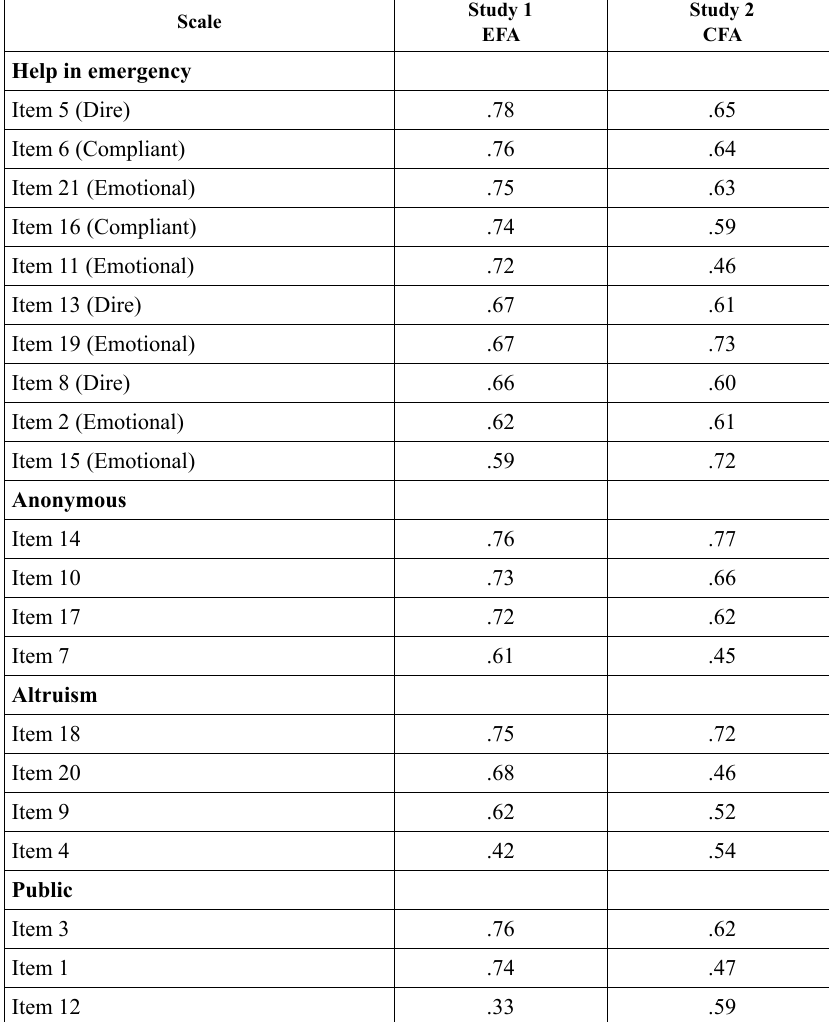
Table 1. Factor loadings for